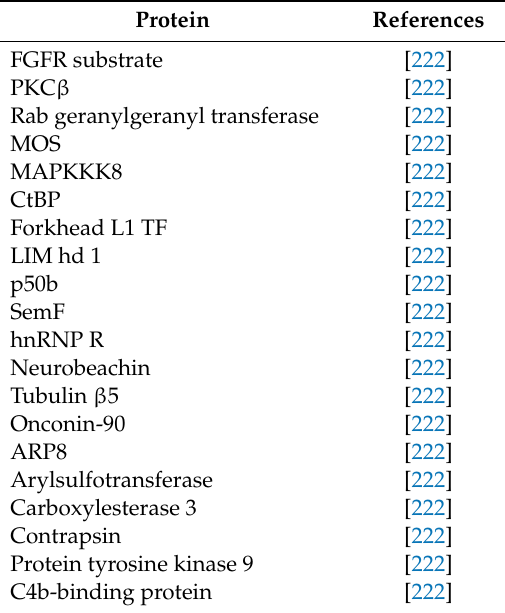
Table 2. Known proteins associated with